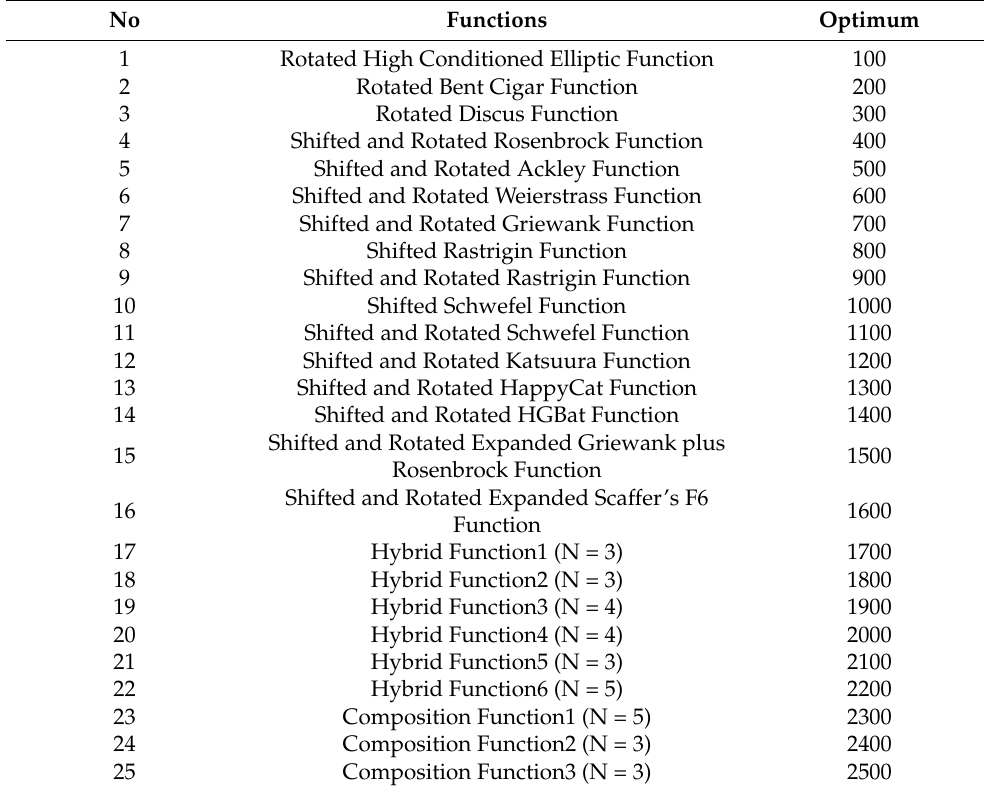
Table A2. CEC2017 functions.